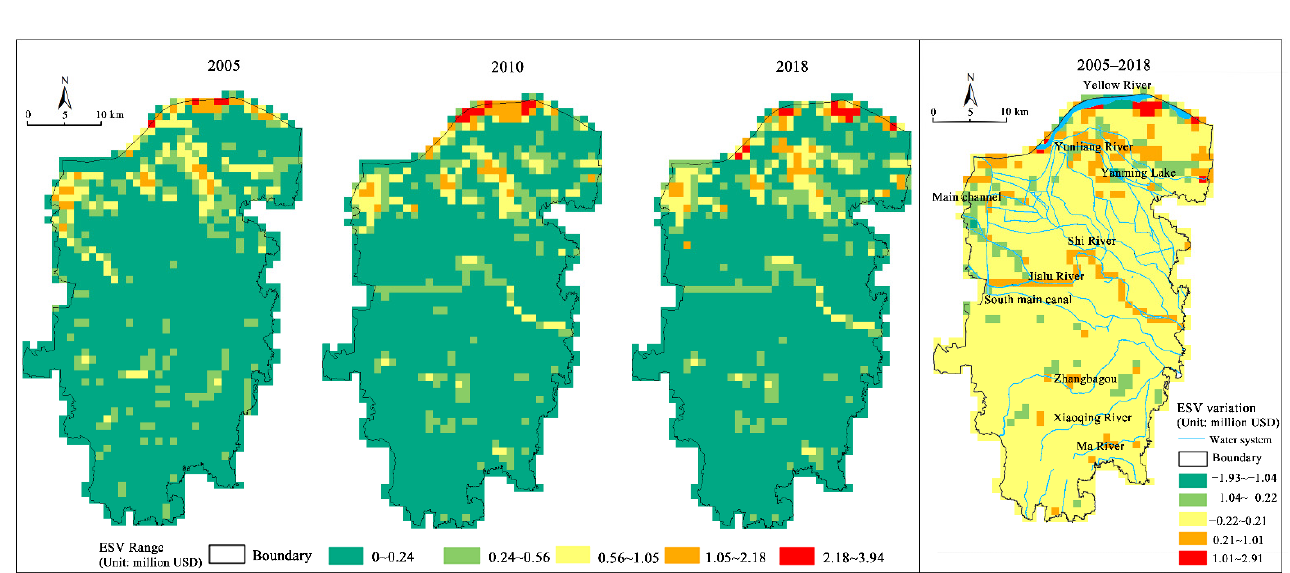
Figure 3. Spatial distribution of ESV and its variation.